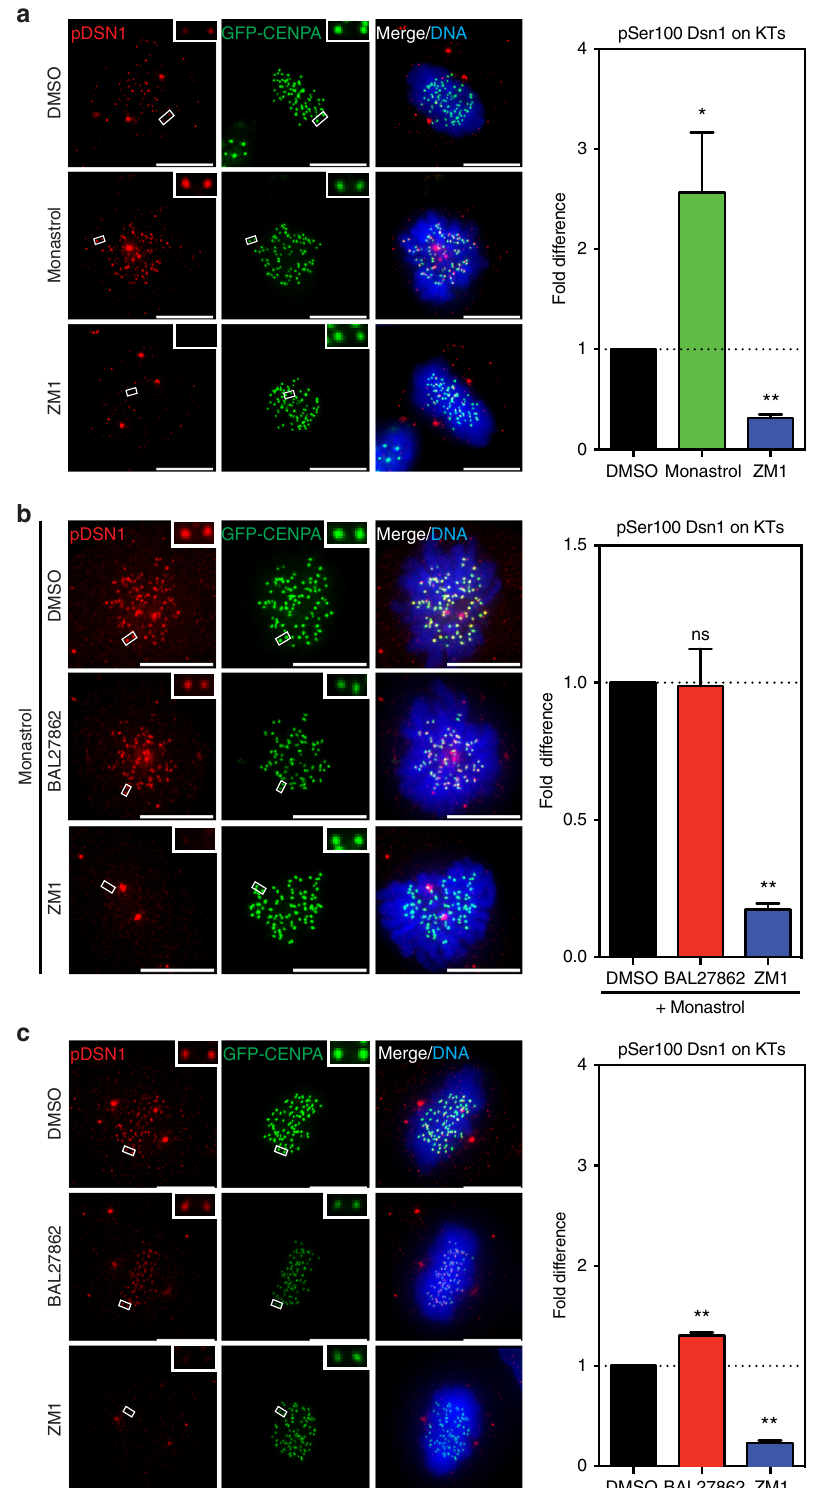
(29 ± 3.1% vs. 20% ± 2.7% in DMSO-treated cells; error bars indicate s.e.m; note that the rare cases of non- disjoined chromosomes, in which two lagging chromosome masses were visible, were excluded from this analysis; N = 9; p = 0.0135 in paired t -test; Fig. 6d). Immuno fl uorescence of fi